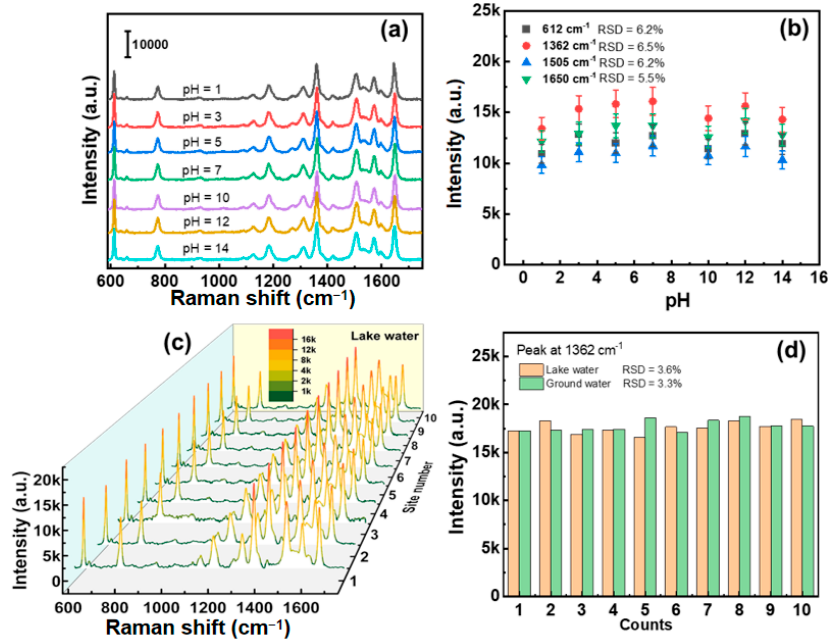
Figure 11. ( a ) SERS spectra acquired from the Au/CuS hybrid substrate immersed in 10 − 7 M R6G solutions with pH values ranging from 1 to 14. ( b ) The absolute peak intensities at 612, 1362, 1505, and 1650 cm − 1 versus the pH values (data from ( a )). ( c ) SERS spectra acquired from the Au/CuS hybrid substrate immersed in lake water (the Dongpu Lake in Hefei, China) with spiked 10 − 7 M R6G on a handheld Raman spectrometer. ( d ) The histograms for the peak intensities of R6G at 1362 cm − 1 (data from ( c ) and Figure S8a).